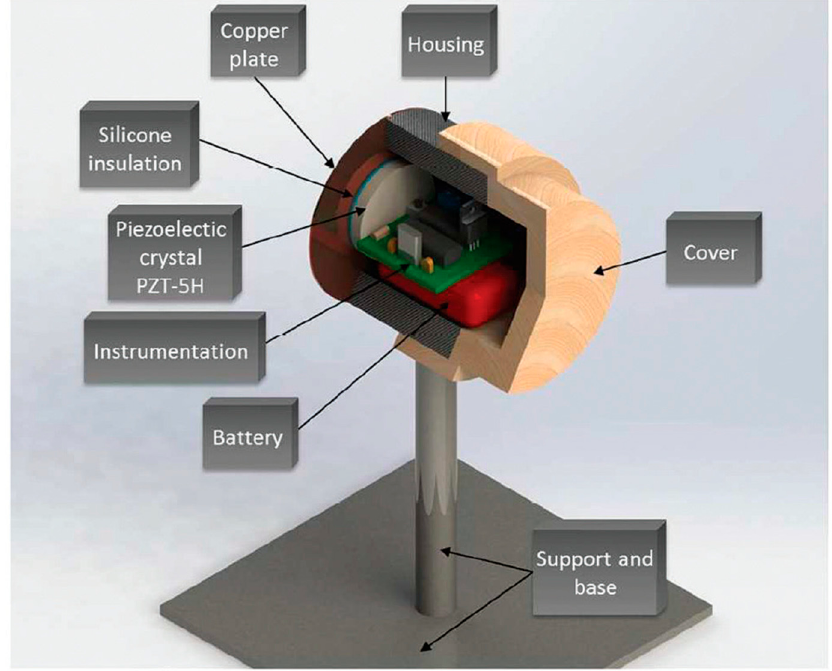
Figure 7. PPM generator components.